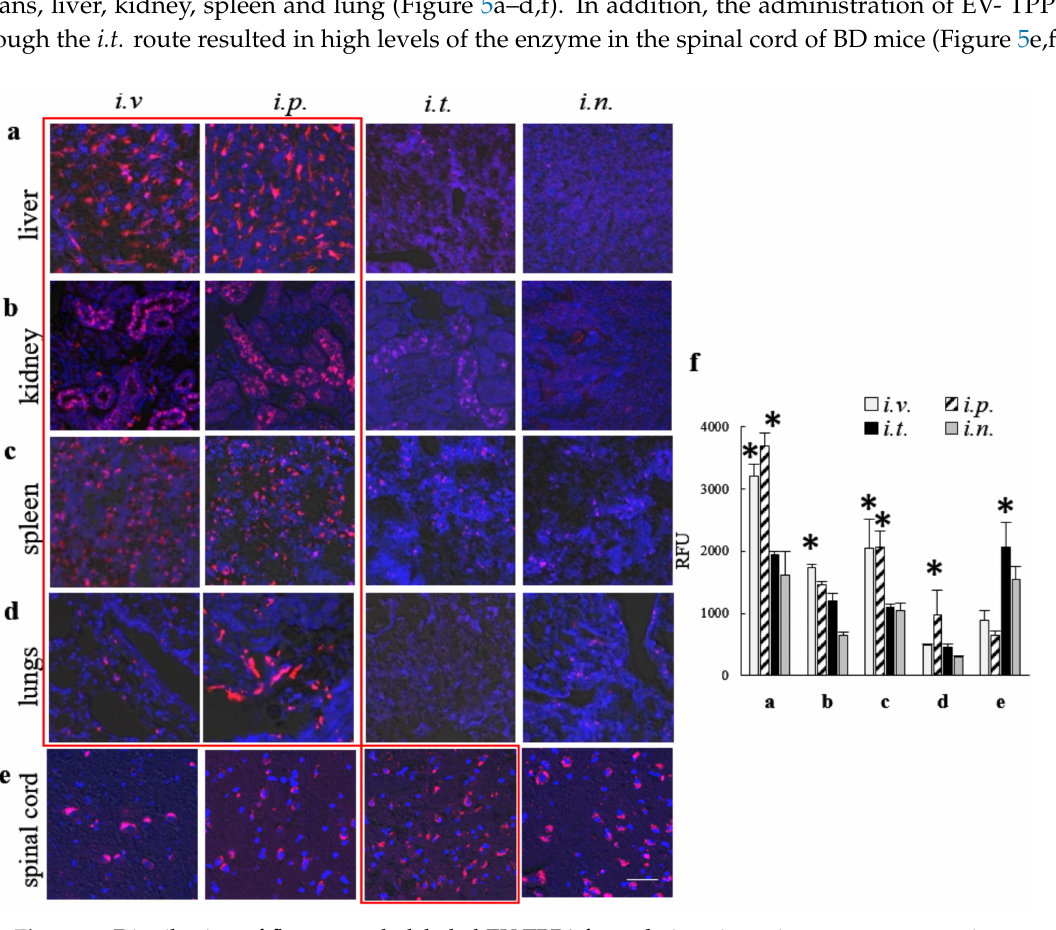
Figure 5. Distribution of fluorescently labeled EV-TPP1 formulations in main organs upon various routes of administration in BD mice. CLN2 KO mice (1 month old, N = 4) were injected with non-labeled EVs loaded with Alexa 555-TPP1 (red), through: i.v. (2 × 10 10 particles / 200 µ L), or i.p. (2 × 10 10 particles / 200 µ L), or i.t . (5 × 10 9 particles / 50 µ L), or i.n. (2 × 10 9 particles / 20 µ L) routs. Then, 72 h later, mice were sacrificed, perfused, main organs, namely: ( a ) liver, ( b ) kidney, ( c ) spleen, ( d ) lungs, and ( e ) spinal cord were processed as described on Figure 3, and examined by confocal microscopy. Nuclei were stained with DAPI (blue). Confocal images ( a – e ), and quantification of Alexa 555 fluorescent signals ( f ) indicated significant accumulation of Alexa 555-TPP1 incorporated into EVs in all peripheral organs, especially after i.v. and i.p. injections. The high Alexa 555-TPP1 signals were recorded in spinal cord after i.t. injection ( e , f ). The bar: 50 µ m. Values are the means ± SEM, * p <